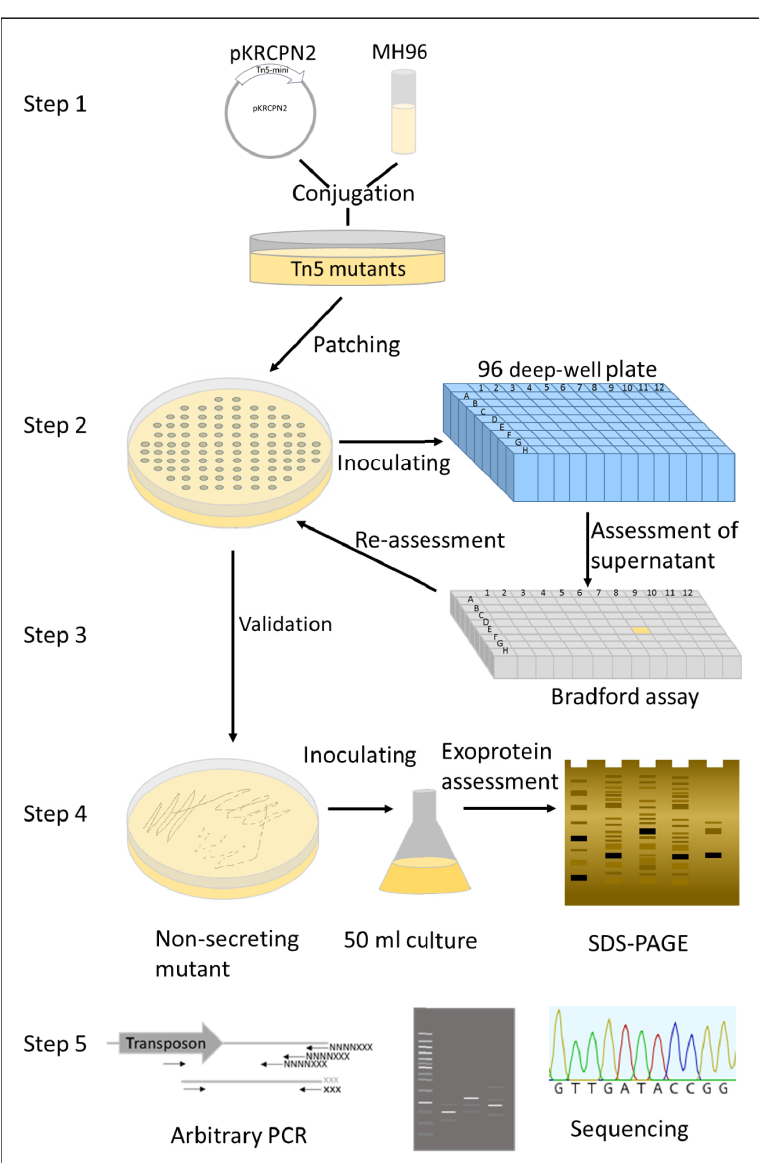
Fig 2. Flowchart of the steps involved in the high-throughput exoproteome screening assay (HESA). Step 1 : Construction of a transposon mutant library by conjugation of E . coli pKRCPN2 (Tn 5 -harboring plasmid) with MH96. Step 2: Eighty random mutants per transformation event were patched onto a selective LB agar plate. The same tip was used to inoculate a single well of a 96-well plate, which was incubated at 25˚C and 200 rpm for 24 h. Step 3: Following centrifugation at 2,200 × g for 15 min, 12 μ L of the supernatant were transferred to a 96-well plate for exoprotein quantification by Bradford assay. Non-secreting mutants were distinguishable by less blue coloration in the assay (indicated as a yellow well). All putative secretion-altered mutants were re-assessed using the protein assay (Steps 2–3) and subsequently stored. Step 4: Mutants with an altered secretion profile were then validated through SDS-PAGE assessment of the exoprotein content derived from 50-mL LB broth cultures at 16 hpi. Step 5: Transposon insertion points within the genomes of non-secreting mutants were determined by arbitrary PCR and the resultant sequences aligned to the MH96 genome sequence (GenBank accession number